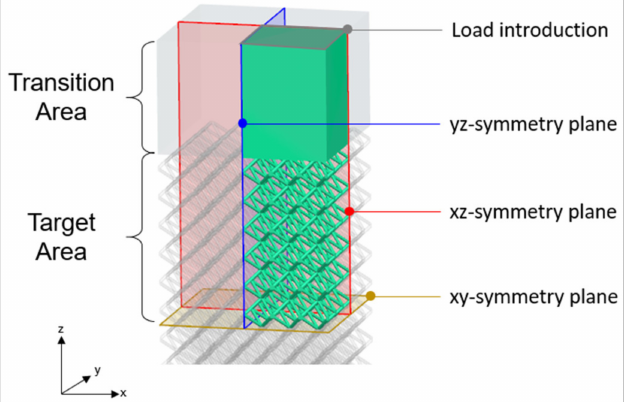
Figure 3. Eighth model representation.